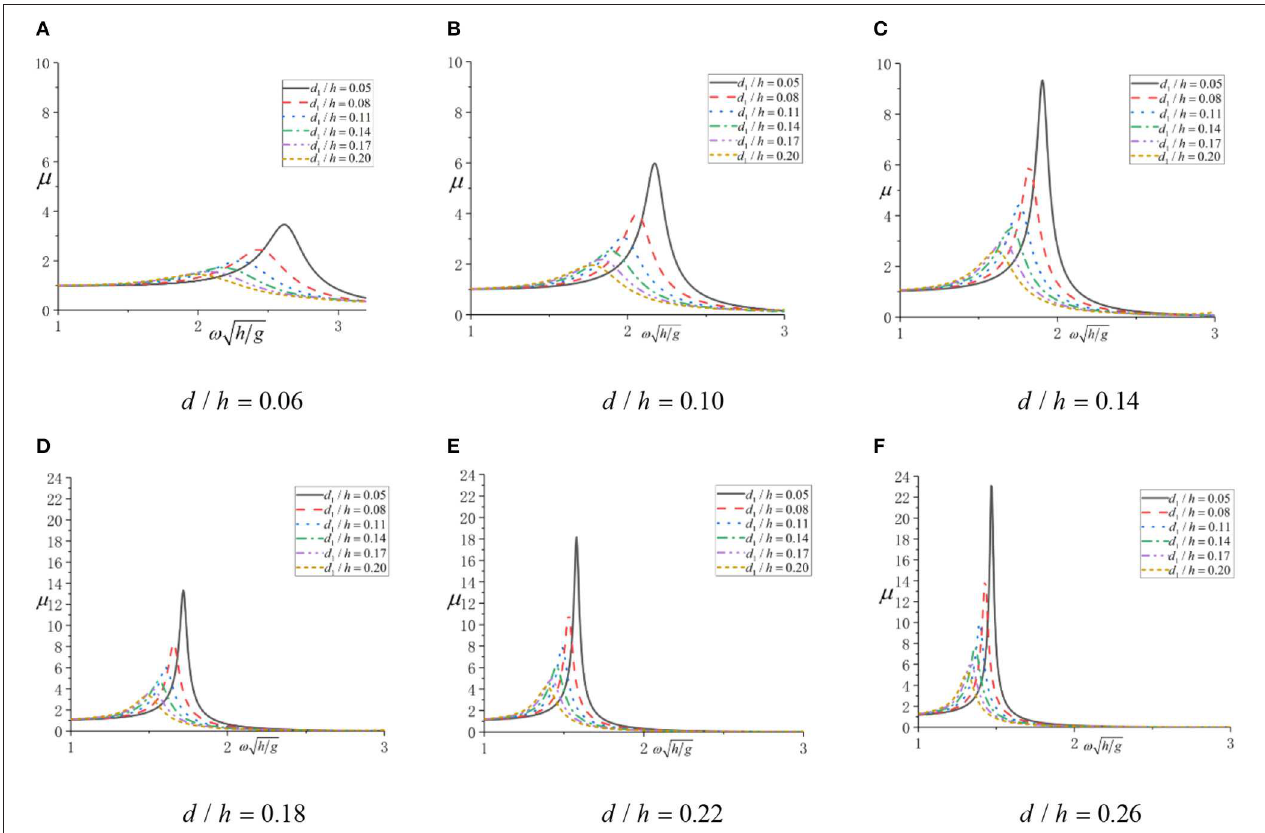
0.06; (B) d / h 0.10; (C) d / h 0.14; = = =